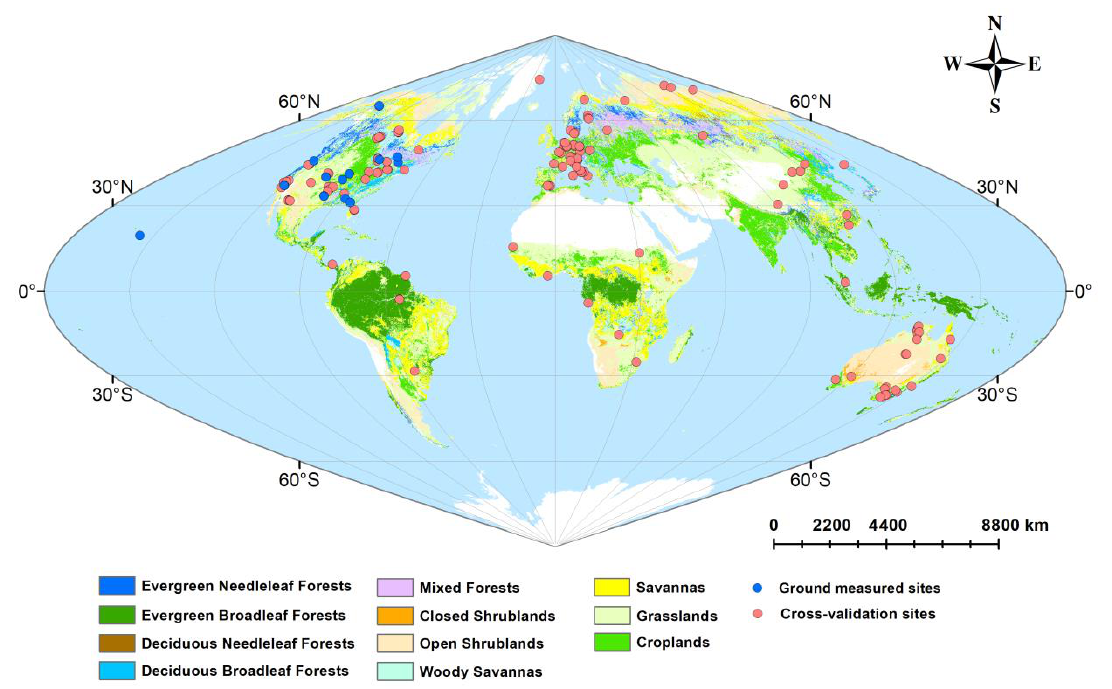
Figure 1. Global MCD12Q1 land cover map and the locations of the ground measurement sites and